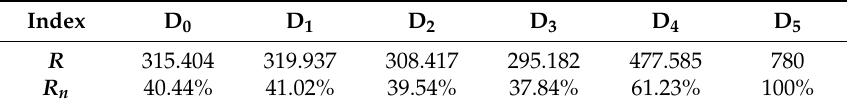
Table 4. Stability index over 780 simulations for each